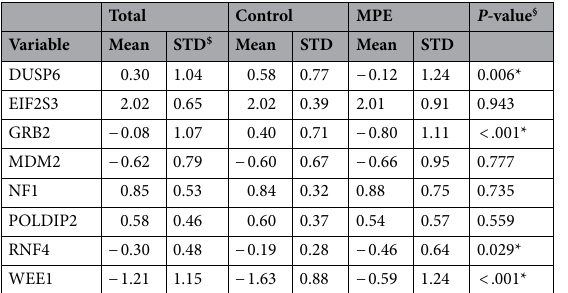
Table 2. Bivariate analyses for the relative gene expression of the molecular markers in malignant pleural effusions. § The two-independent sample T was used, * P- value < 0.05, STD standard deviation.